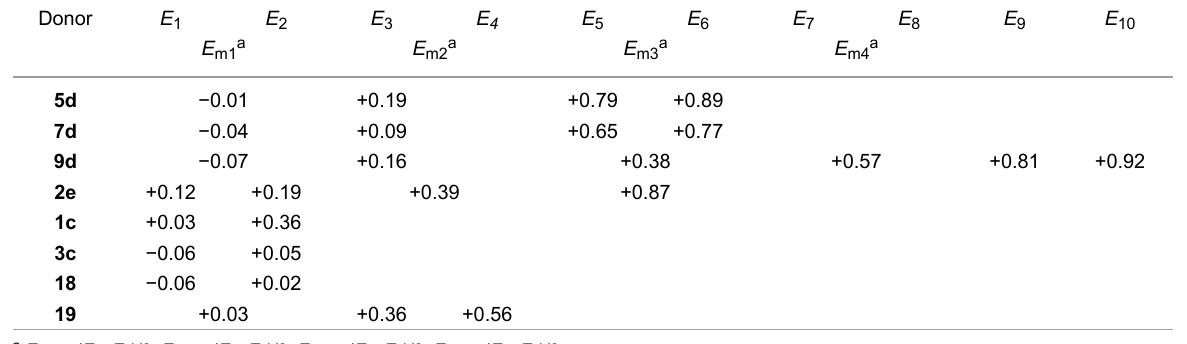
Table 2: Redox potentials of 5d , 7d , 9d and their related compounds (V vs Fc/Fc + , in benzonitrile/carbon disulfide 1:1, v/v).